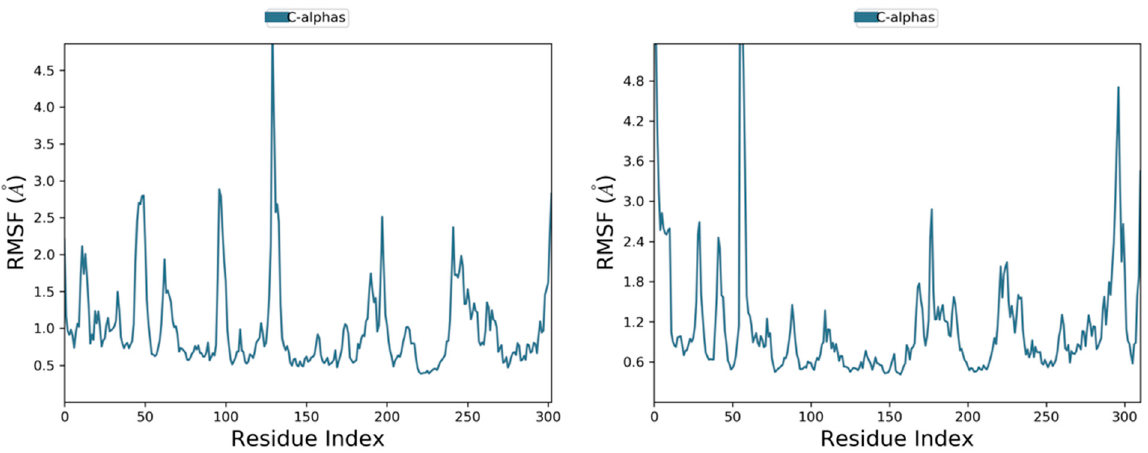
Figure 10. Residue wise Root Mean Square Fluctuation (RMSF) of 7j-VEGFR 2 and 7j-EGFR com- plex with